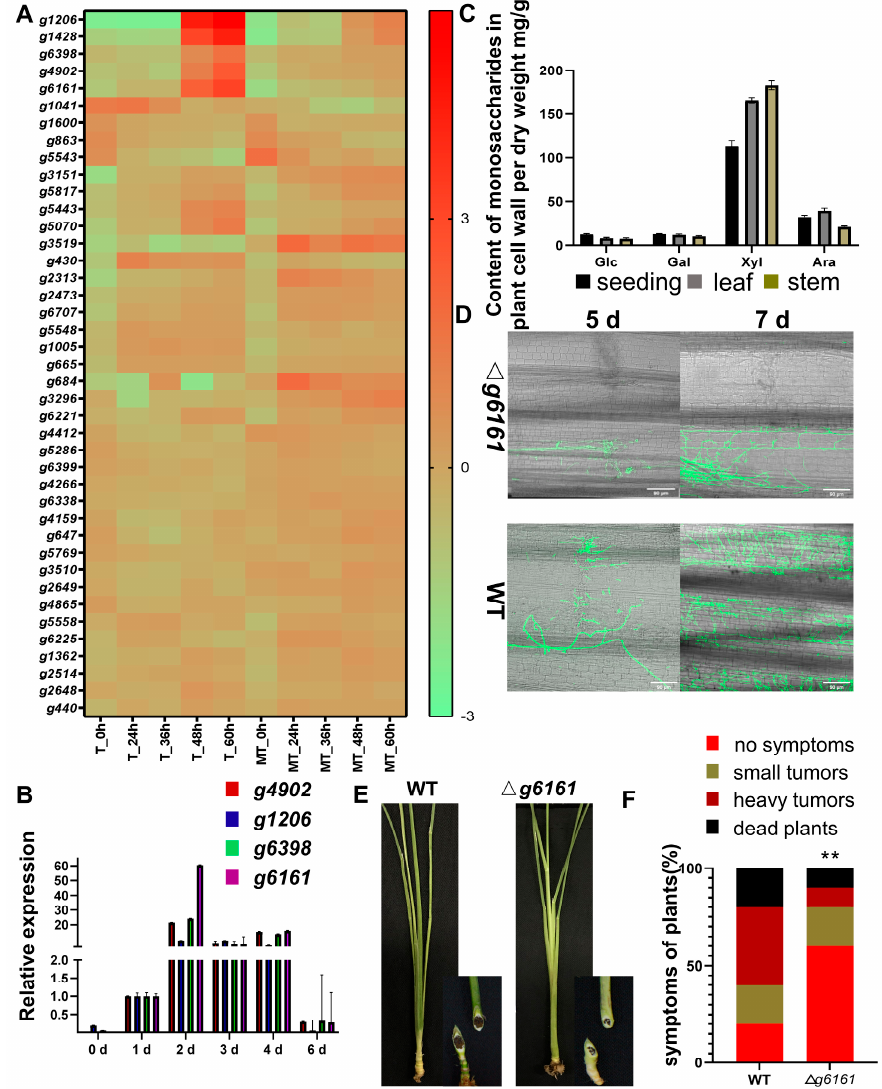
Figure 4. Expression pattern and virulence function of genes related to carbohydrate metabolism. ( A ) The heat map shows the expression profiles of the carbohydrate metabolism-related genes in U. esculenta . Log2 expression values are visualized relative to the mean expression level across all stages. ( B ) The expression trend of genes encoding endo-1,4-beta-glucanases ( g1206 and g4902 ), pectin lyase ( g6398 ), and endo-1,4-beta-xylanase ( g6161 ). Two compatible haploids of T-type (UeT14 + UeT55) were mixed and inoculated to host plants. Gene expressions were evaluated at 0, 1, 2, 3, 4, and 6 days post-inoculation by RT-qPCR (Mean ± SD, number of replications = 8). ( C ) Monosaccharide content in plant cell wall per dry weight of different tissue (seedings, leaves, stems) of Z. latifolia (Mean ± SD, number of replications = 6). The plant cell wall was hydrolyzed by trifluoroacetic acid and analyzed by HPLC. ( D ) Observation of infection status on the leaf surface. The mixtures of compatible strains were injected into the stems of Z. latifolia . Samples were collected at 5 and 7 days post-inoculation, stained with WGA-FITC, and analyzed by laser scanning confocal microscopy. The combination of Δ g6161 ( UeT14 Δ g6161 and UeT55 Δ g6161 ) was studied, and wild-type strains (UeT14 and UeT55) were set as a positive control. Green fluorescence indicates mycelia of U. esculenta. The scale bar represents 90 μ m. ( E ) The symptom of representative plants at 90 days post-inoculation. The cross-section of the stem is shown in the lower right corner. ( F ) The symptoms of inoculated host plants were scored 90 days later according to severity (number of replications = 100). Statistically significant difference with wild-type control: ** p < 0.01.